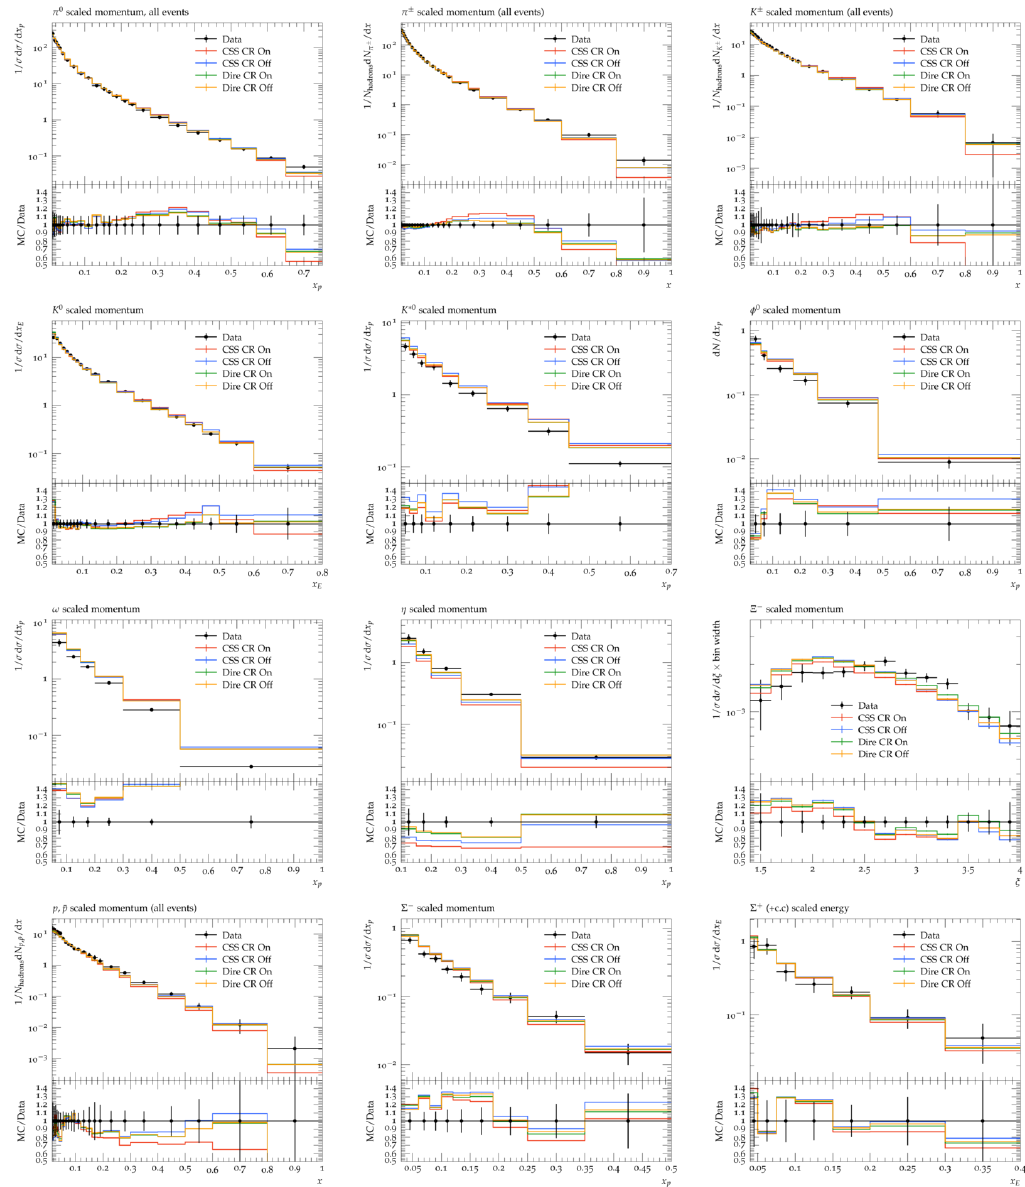
Figure 8: From left to right, first row: x distributions for π 0 from (D ELPHI [ 54 ] ), π ± p and K ± from D ELPHI [ 55 ] ; second row: K 0 from O PAL [ 56 ] ), K ∗ 0 from D ELPHI [ 57 ] , φ from S LD [ 58 ] ; third row: ω and η from A LEPH [ 59 ] , Ξ − from D ELPHI [ 60 ] ; fourth for Σ + from O PAL [ 62 ] row: p , ¯ p from D ELPHI [ 55 ] , Σ − from D ELPHI [ 61 ] and x E